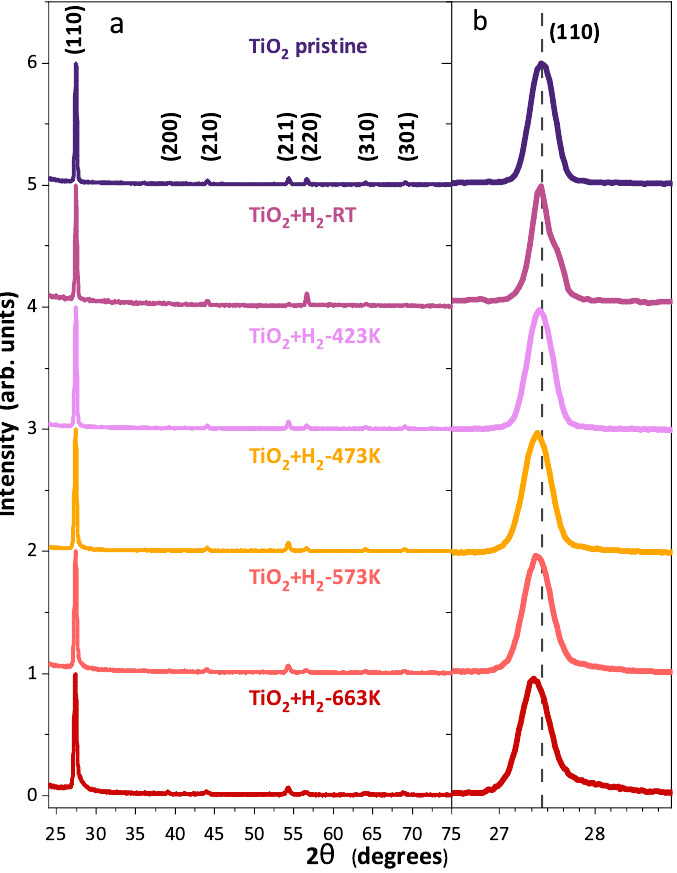
Figure 2. GIXRD patterns of hydrogenated rutile ( a ) and ( b ) the magnified (110) reflex demonstrating a gradual